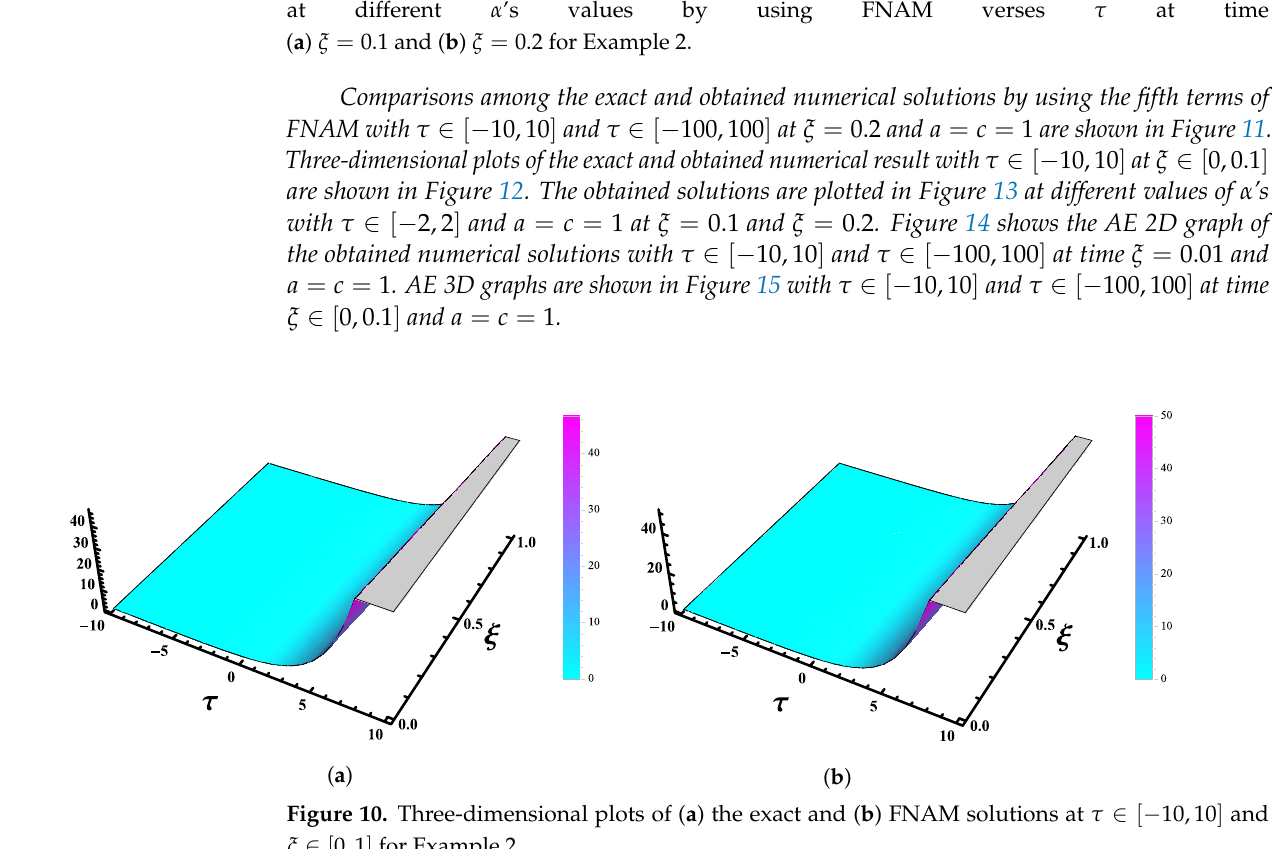
Figure 9. Two-dimensional plots of numerical solutions at different α ’s values by using FNAM verses τ at time ( a ) ξ = 0.1 and ( b ) ξ = 0.2 for Example 2.